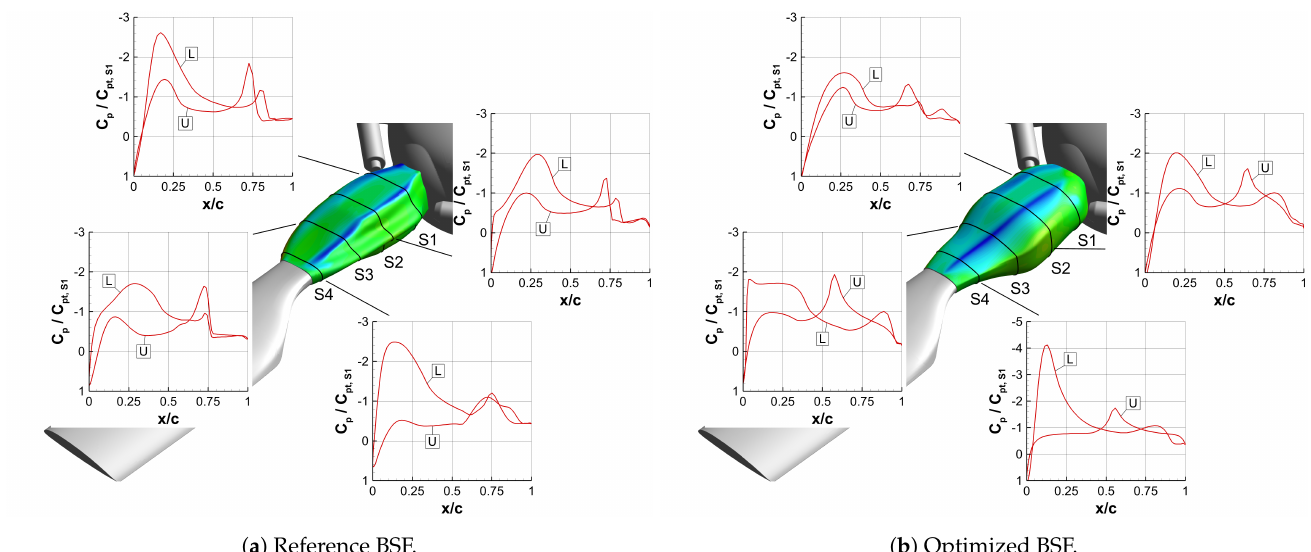
Figure 19. Comparison of the normalized, chord-wise surface pressure distribution C p / C pt , S 1 ( x / c ) at four radial sections S1-S4 considering the advancing rotor blade position ( Ψ = 90 ◦